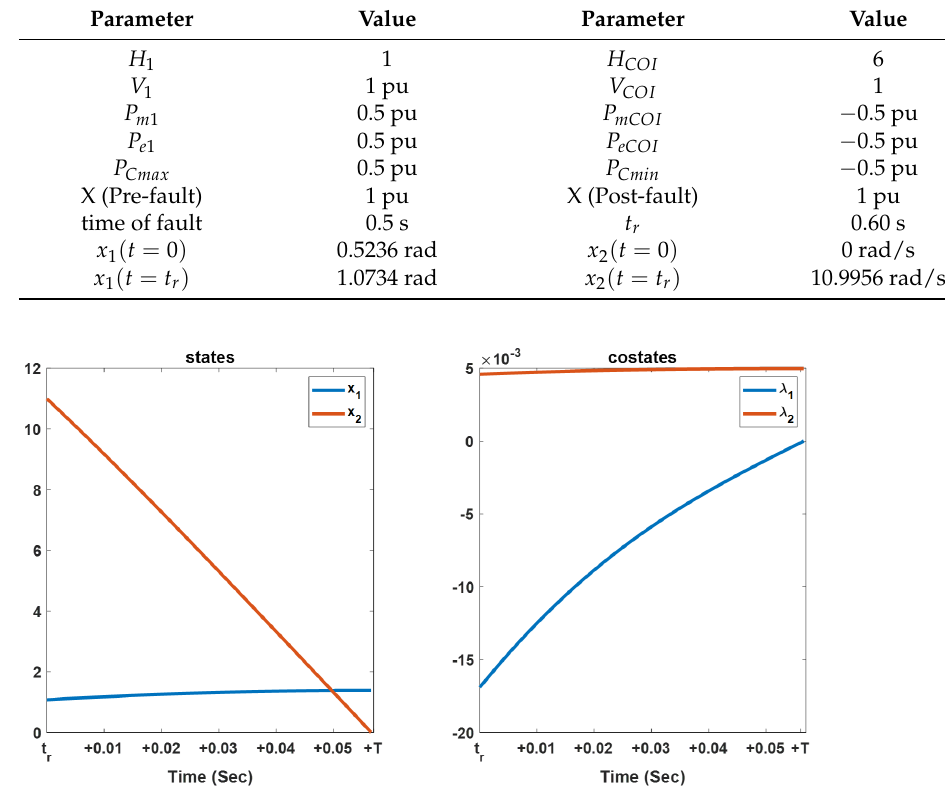
Figure 10. States trajectory for the optimal control problem.